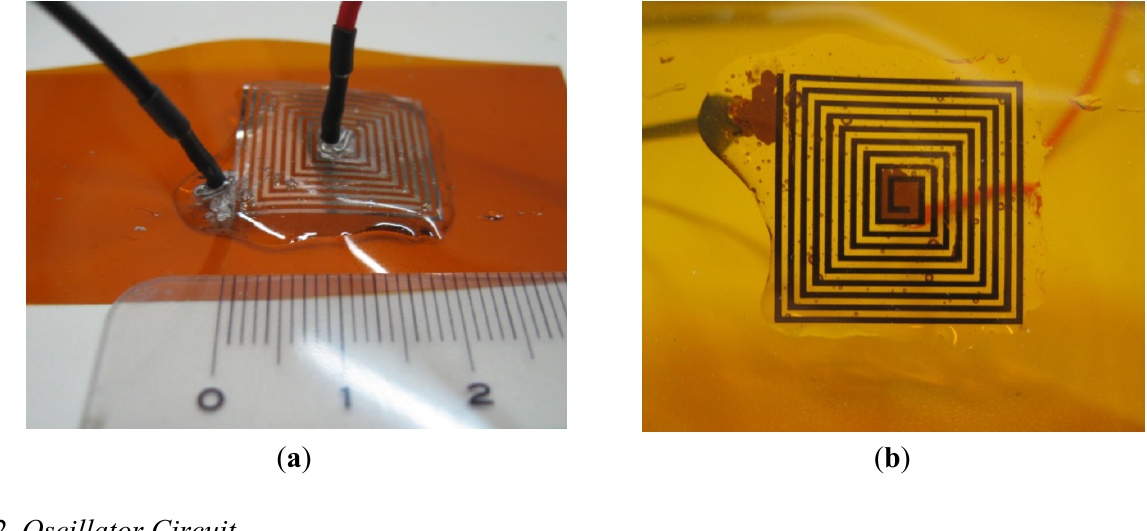
Figure 6. ( a ) Top and ( b ) bottom side of the printed inductor with